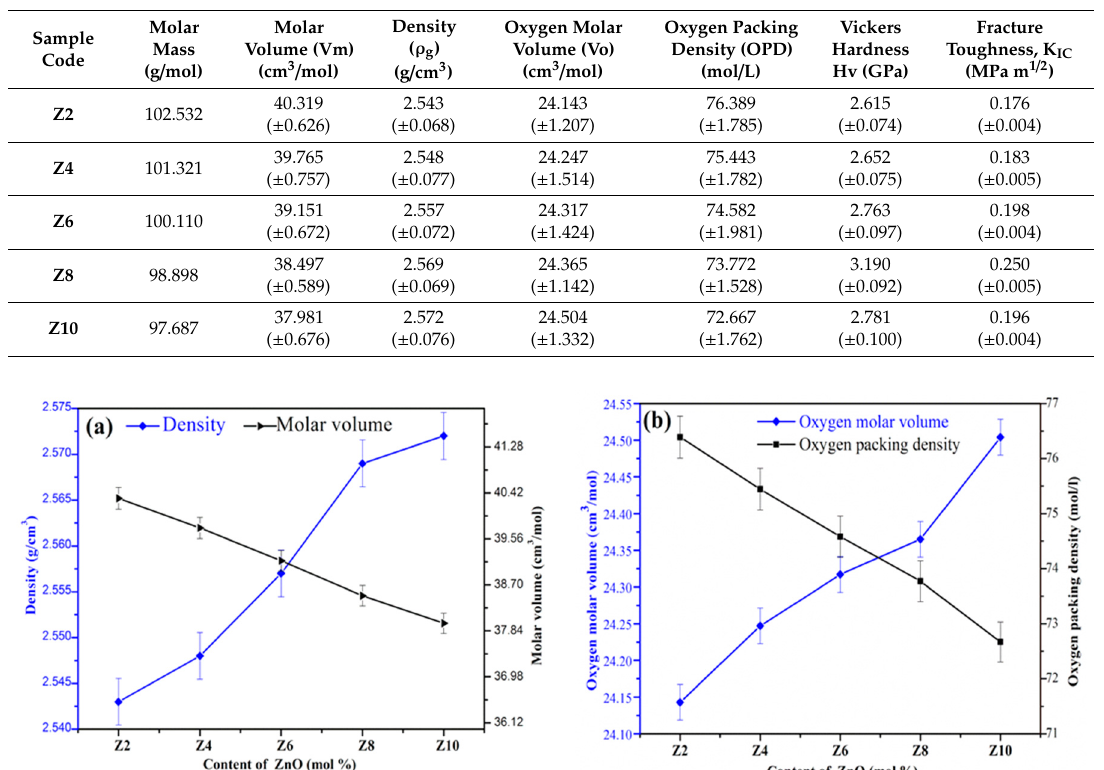
Table 2. Physical parameters of the ZnO–Na 2 O–CaO–P 2 O 5 glass system.